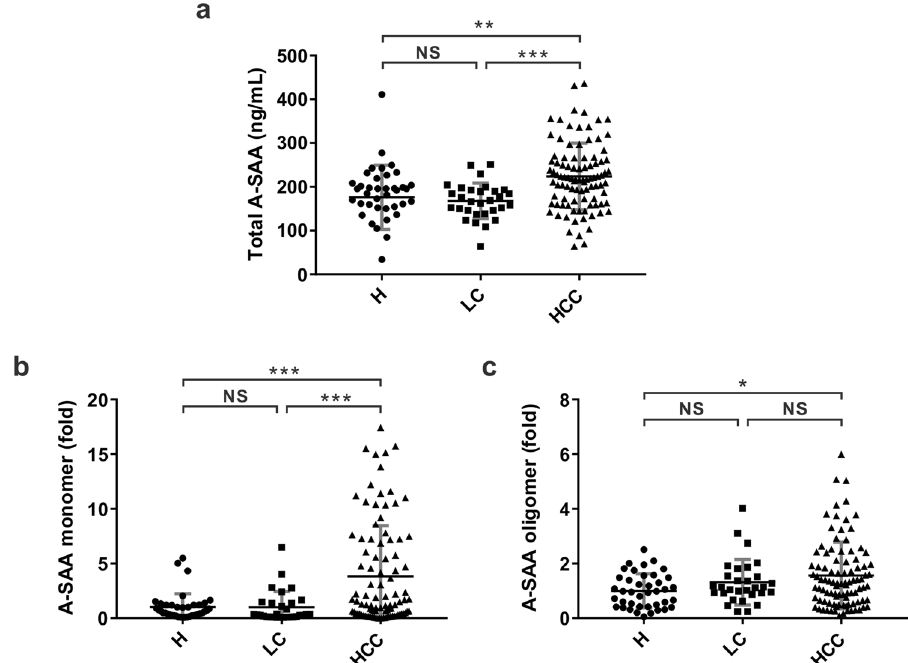
Figure 1. Comparison of A-SAA derived biomarker levels among hepatitis, LC, and HCC patients. A total of 166 serum samples from 40 hepatitis (indicated as H), 30 LC, and 96 HCC patients were measured